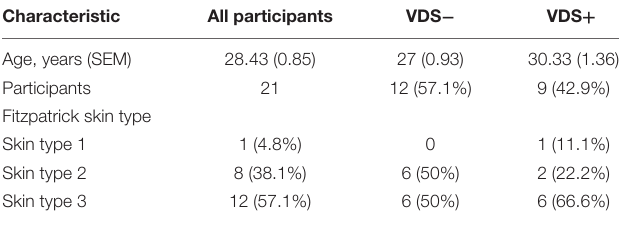
TABLE 1 | Baseline characteristics of study